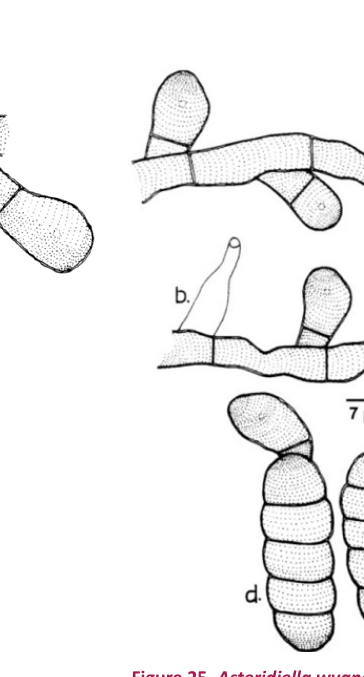
Figure 25. Asteridiella wyanadensis a - Appressorium; b - Phialide; d -